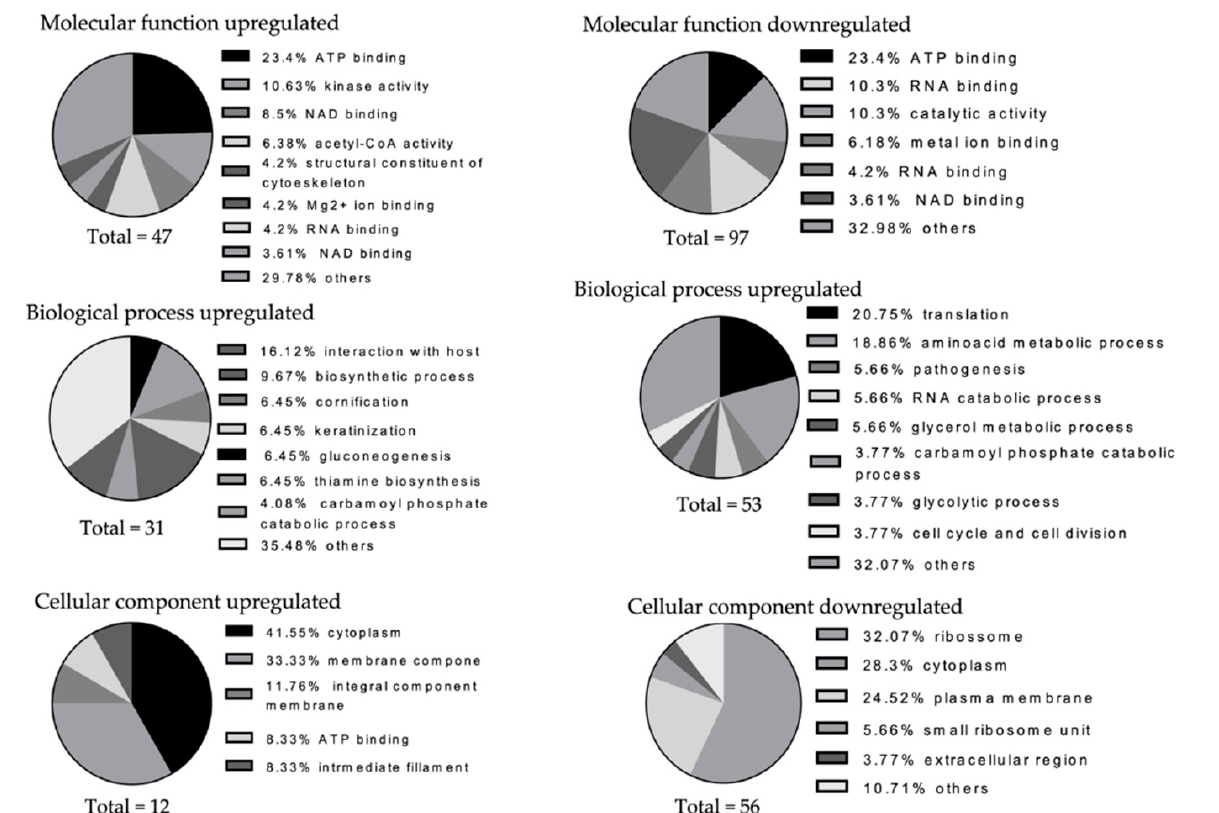
Figure 4. Annotation of regulated bacterial protein functions by gene ontology (GO) term enrichment. The comparison was performed between both S. aureus implementing biofilms (6S + USA300-MRSA WT versus the 6S + USA300-MRSA ∆ MSCRAMM biofilm). The GO terms from all regulated proteins were categorized into three categories: molecular function, biological process, and cellular component, as displayed in the pie charts. The numbers of GO terms for each of the three categories are shown, whereas the proportion of each specific subcategory is also provided. Subcategories with GO terms less than 2% are classified as “others”. Total numbers are related to the total numbers of regulated